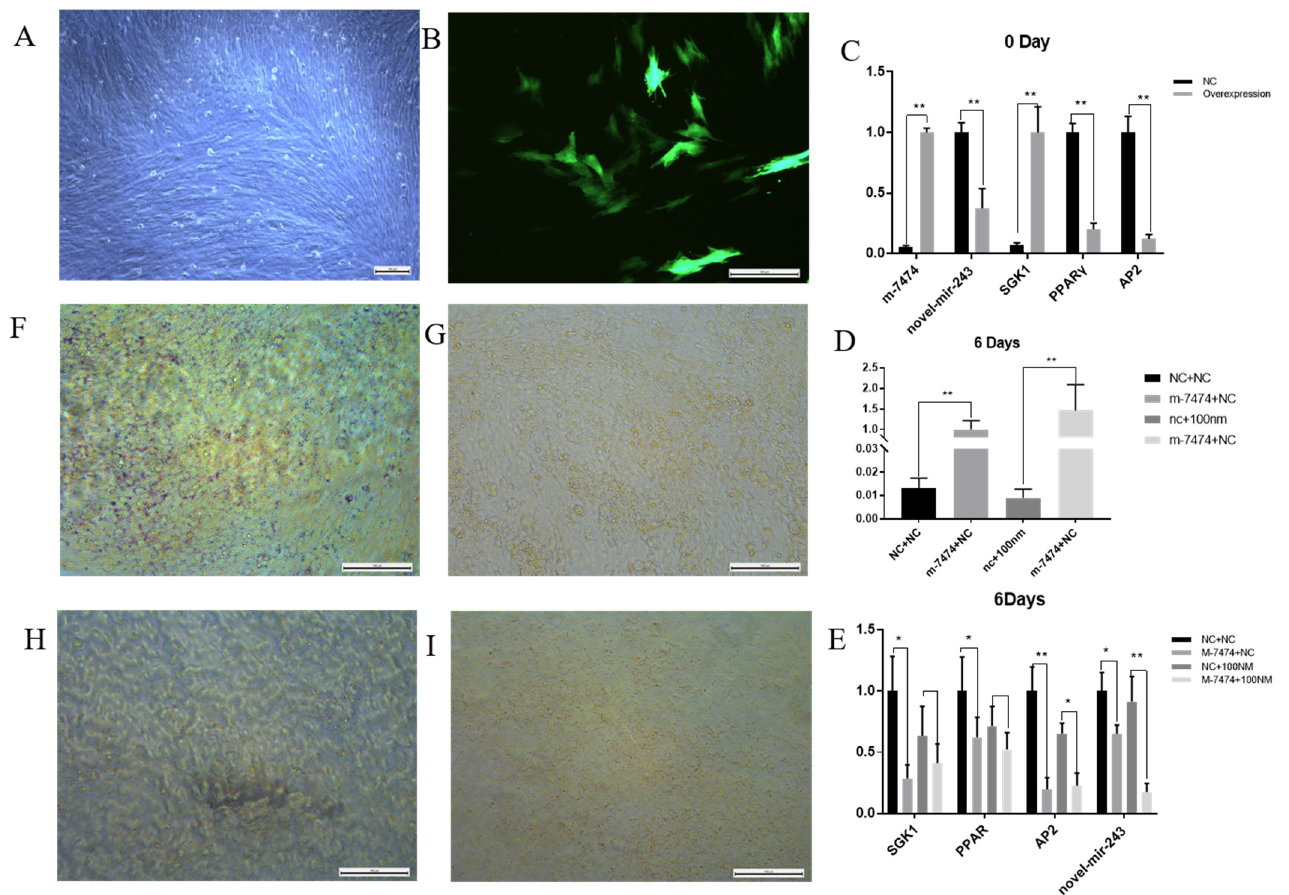
Figure 7. Preadipocyte differentiation experiment of the M-7474-overexpressing group. ( A ). Bright field image of preadipocytes overexpressing M-7474. ( B ). Fluorescent image of the anterior adipocytes after overexpression of M-7474. ( C – E ). qPCR quantification of related genes. ( F ). Oil red O staining was performed 6 days after differentiation in the NC group without testosterone addition. ( G ). Oil red O staining was performed 6 days after differentiation in the overexpressed M-7474 group without testosterone addition ( H ). The NC group was differentiated with 100 nm testosterone for 6 days after oil red O staining ( I ). The overexpressed M-7474 group was differentiated with 100 nm testosterone for 6 days after oil red O staining. NC indicates control group, M-7474 indicates lncRNA overexpression group, Nc + 100 nM indicates NC group was added with 100 nm testosterone, M-7474 + NC indicates lncRNA overexpression group was added with 100 nm testosterone. * indicates p < 0.05, ** indicates p < 0.01.